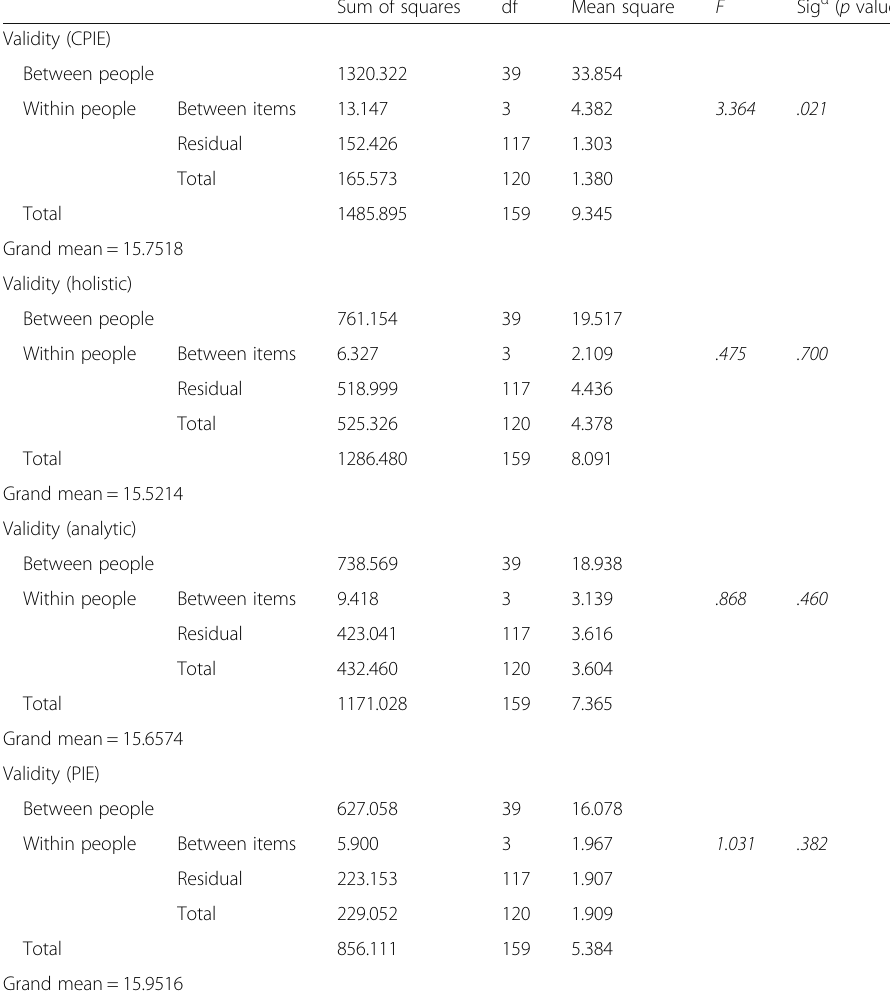
Table 6 Validity of the Four Methods (SPSS 2017) ( α level: 0.05) Sum of squares df Mean square F Sig α ( p